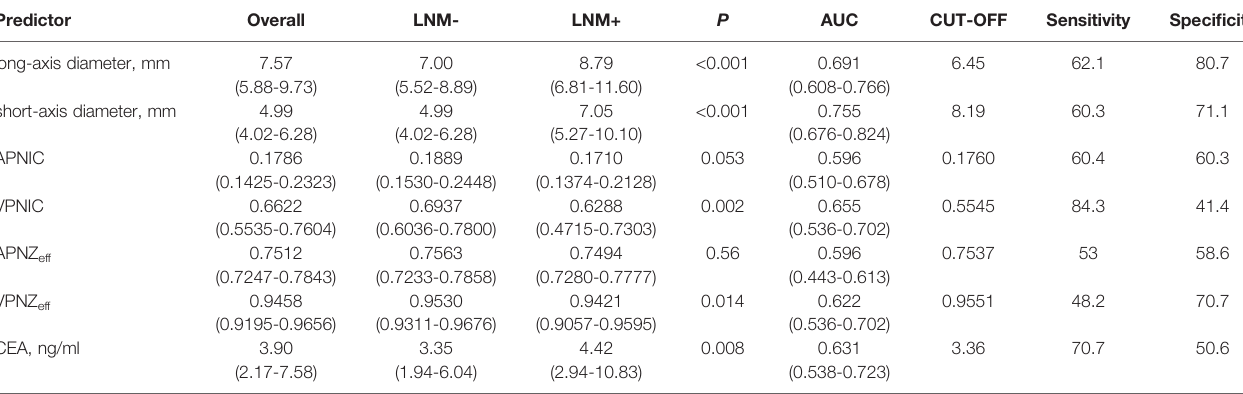
TABLE 4 | Comparison of morphology predictors, CEA and DECT quantitative parameters on distributions, AUCs, cut-offs, sensitivities and speci fi cities. Predictor